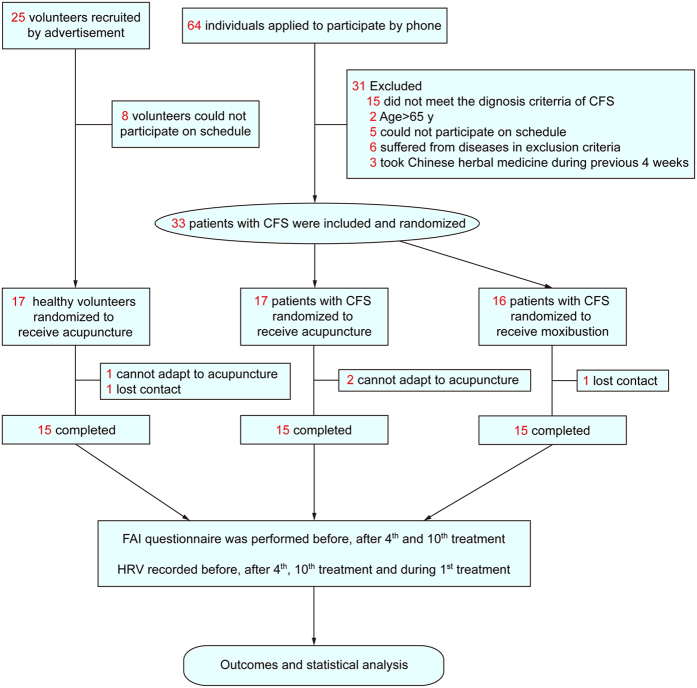
Flow of participants.